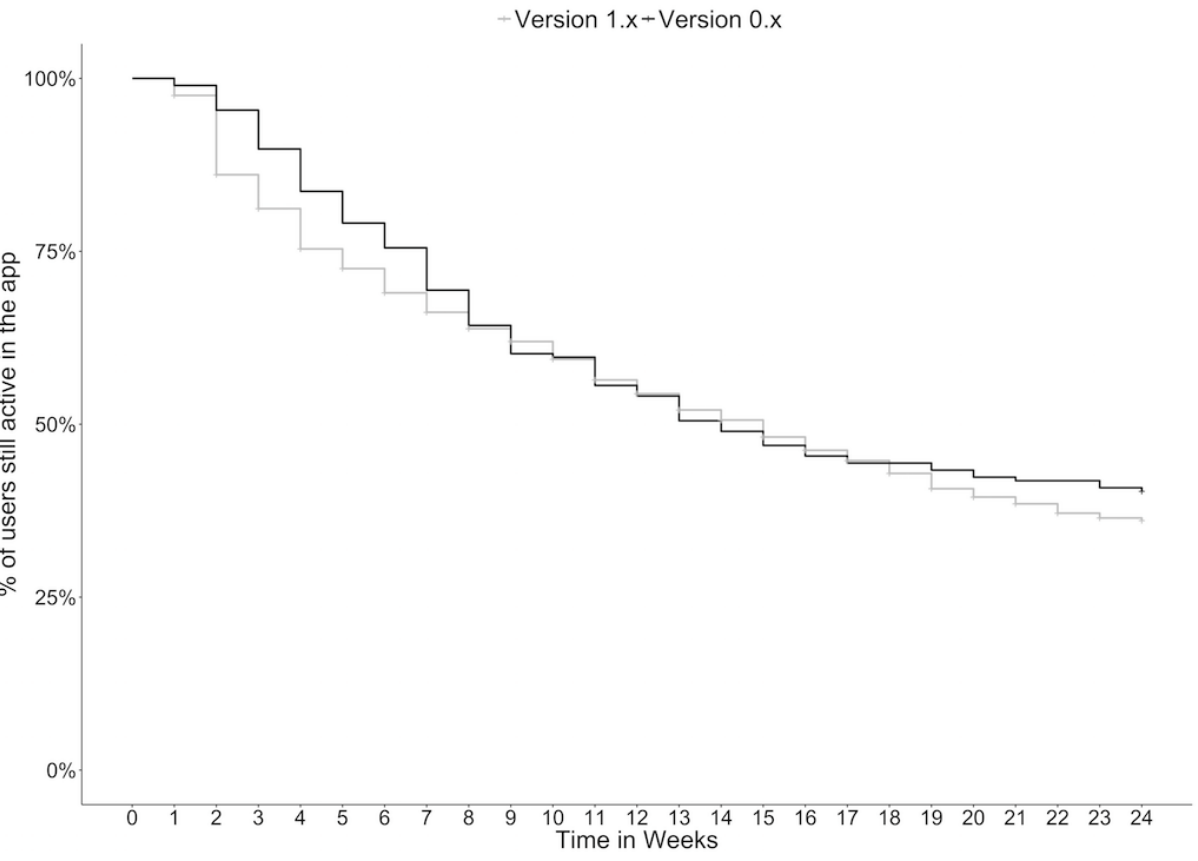
Figure 1. Kaplan-Meier plot of dropout of users in percentage over time in